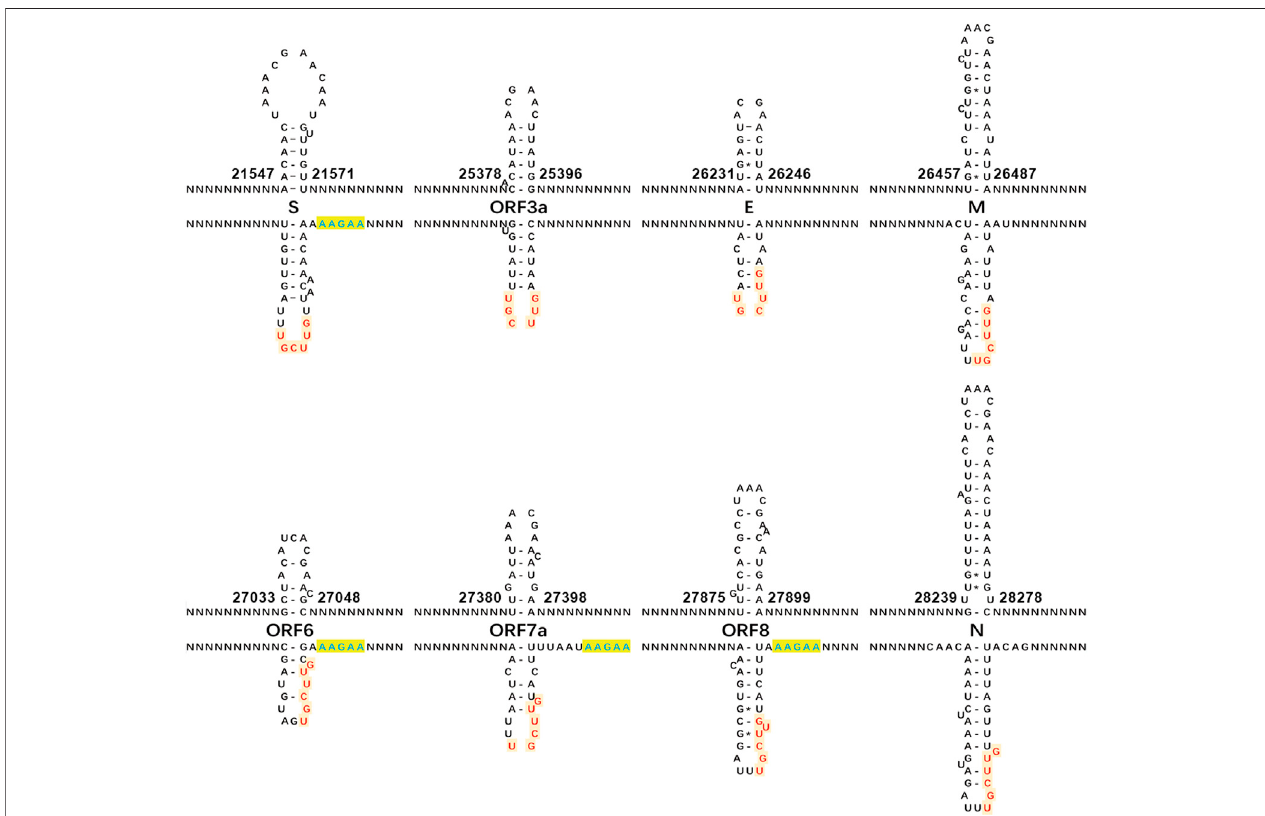
FIGURE 2 | Canonical TRS hairpins in SARS-CoV-2. The canonical transcription regulatory sequence (TRS) motif ACGAAC is present in the upstreams of eight genes ( S , E , M , N , and ORF3a , 6 , 7a and 8 ).Read on the antisense strands of the SARS-CoV-2 genome (GenBank: MN908947.3), “ AAGAA ” (in blue color) or “ AAACH ” ( Supplementary Table S1 ) represents an RNA methylation site, while “ GUUCGU ” (in red color) represents a NSP15 cleavage site. The positions are the start and end positions of hairpins in the SARS-CoV-2 genome. NSP15 cleaves a single-strand RNA after U (indicated by arrows). In the present study, we de fi ned: (1) the hairpins containing the canonical and non-canonical NSP15 cleavage sites are canonical and non-canonical TRS hairpins, respectively; and (2) the hairpins opposite to the TRS hairpins as the opposite TRS hairpins.